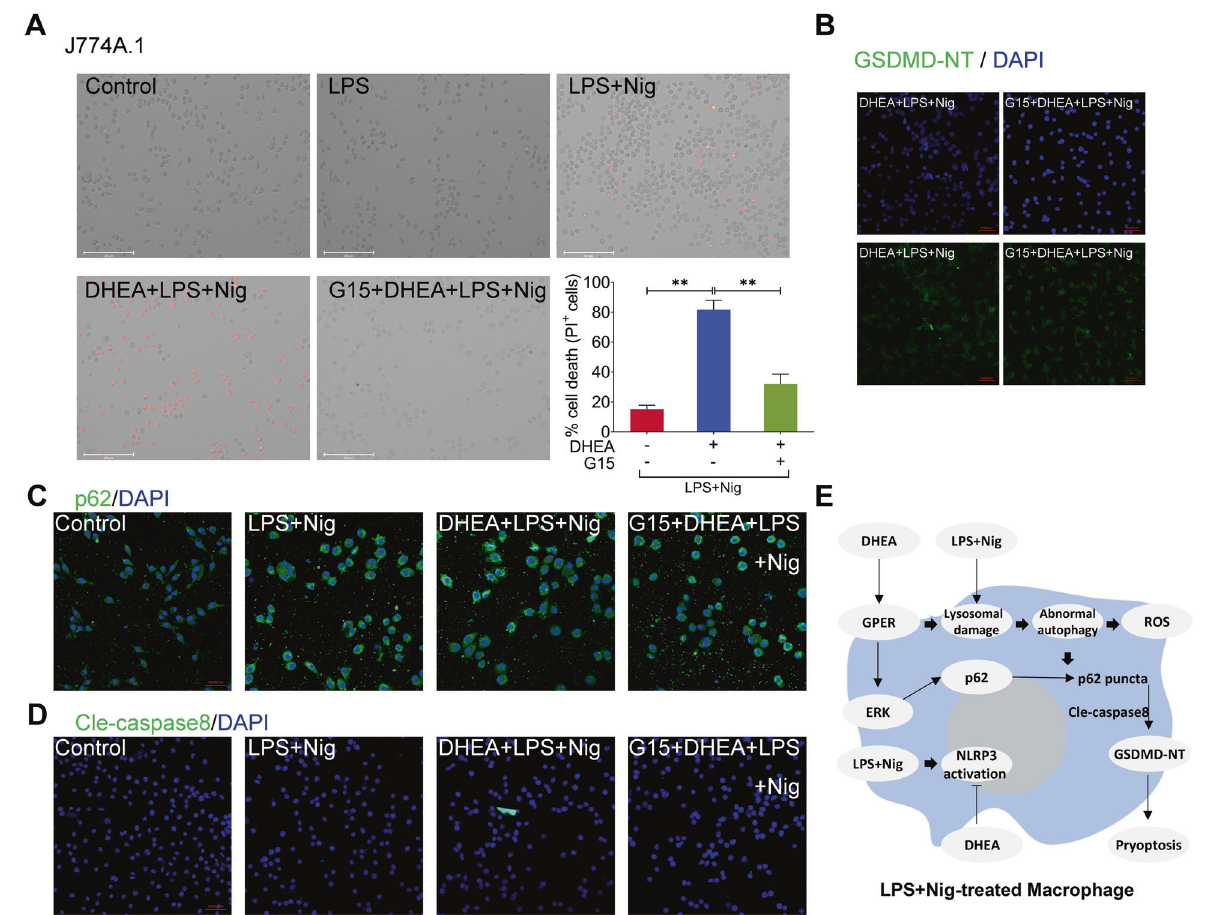
Fig. 6 DHEA exacerbates Nig-induced pyroptosis in LPS-primed macrophages via GPER activation. A J774A.1 cells were pre-treated with DHEA (50 μ M) in the presence or absence of the GPER inhibitor G15 (1 μ M) for 1 h, then stimulated with LPS for 4 h, PI-positive dead cells in 5 randomly selected fl uorescence microscope images were counted by Image J software, scale bar = 200 μ m. B The GSDMD-NT protein levels were analyzed by immuno fl uorescence, scale bar = 50 μ m. C The p62 puncta formation was analyzed by immuno fl uorescence, scale bar = 50 μ m. D The cleaved caspase-8 protein levels were analyzed by immuno fl uorescence, scale bar = 50 μ m. E Possible mechanism by which DHEA exacerbates cell death. Data are presented as means ± SEM ( n = 3). ** P < 0.01, compared with the respective